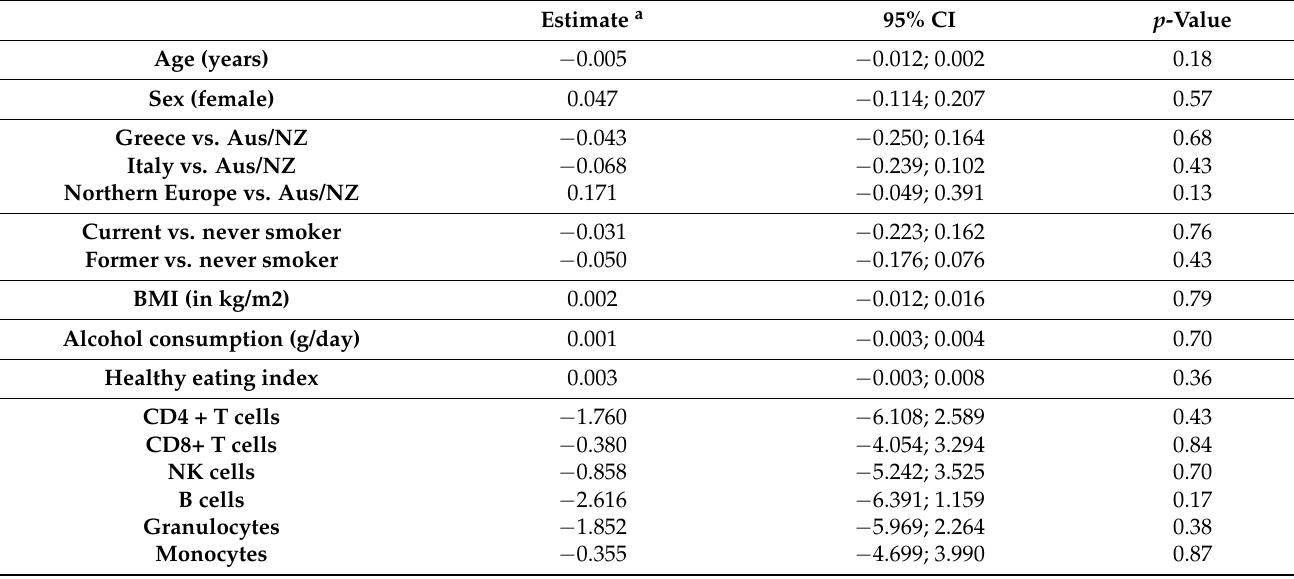
Table 4. Association of non-genetic factors with VTRNA2-1 blood DNA methylation (cg06536614) in the prospective, population-based study; 4500 participants in the Melbourne Collaborative Cohort Study (MCCS).